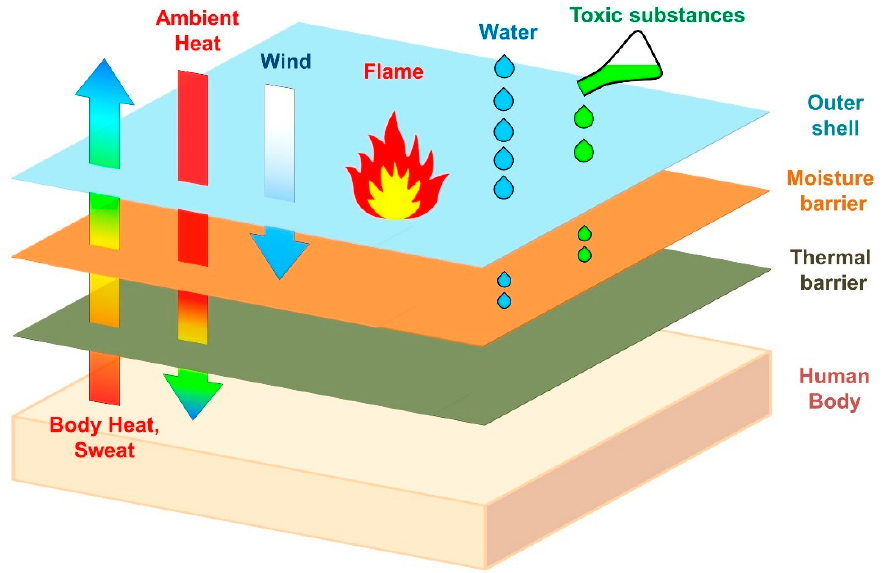
Figure 1. Scheme of the construction of a multilayer assembly used in firefighters’ protective cloth- ing.